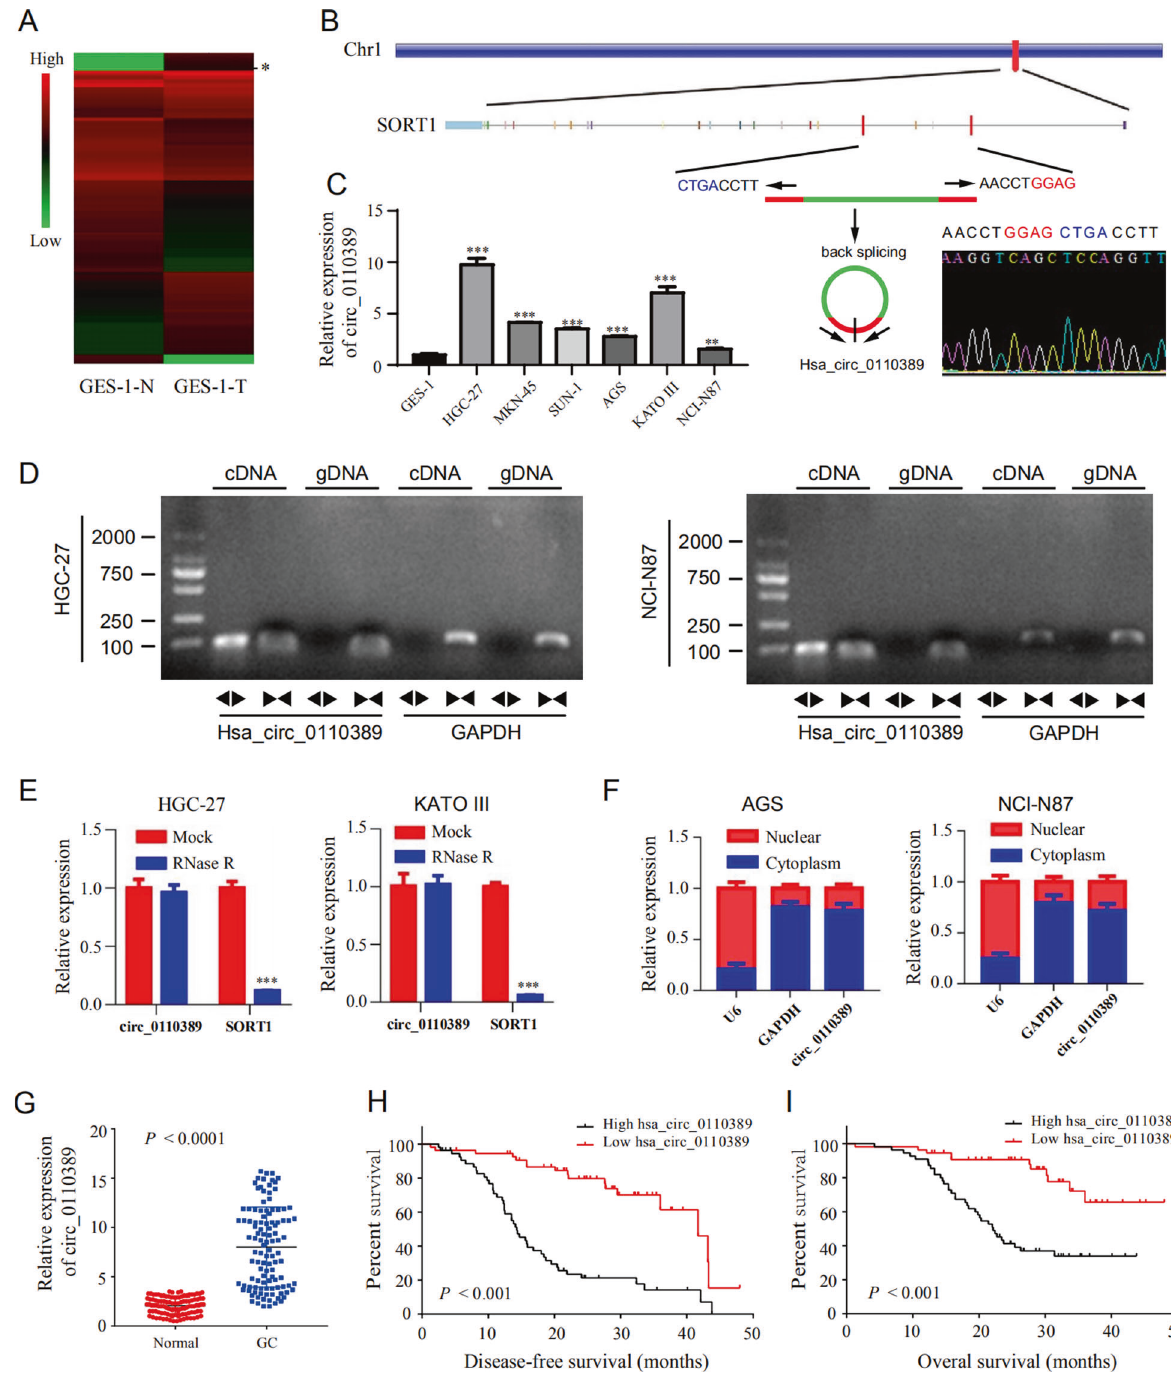
Fig. 1 Hsa_circ_0110389 is up-regulated in gastric cancer tissues and predicts poor prognosis. A Heat map of RNA-seq analysis between GES-1-T and GES-1-N cells. The asterisk indicates hsa_circ_0110389. B Schematic illustration of hsa_circ_0110389 formation via the circularization of exons in SORT1 gene. Sanger sequencing conformed the head-to-tail splicing of hsa_circ_0110389. C Expression of hsa_circ_0110389 in different cell lines. D The gel electrophoresis validated the existence of hsa_circ_0110389. Divergent primers ampli fi ed hsa_circ_0110389 in cDNA but not in gDNA. GAPDH was used as a linear control. E Expression of hsa_circ_0110389 and SORT1 mRNA in both HGC-27 and KATO III cells was detected by qRT-PCR in the presence or absence of RNase R. F Hsa_circ_0110389 was mainly located in the cytoplasm by nuclear-cytoplasmic fractionation assay. G Relative expression of hsa_circ_0110389 in 110 paired GC tissues and adjacent normal tissues. H , I Kaplan – Meier survival analysis (log-rank test) showed that GC patients with high hsa_circ_0110389 expressions have a lower disease-free survival and overall survival than these with low hsa_circ_0110389 expressions ( P < 0.05). All data are presented as mean ± SD. *** P < 0.001.